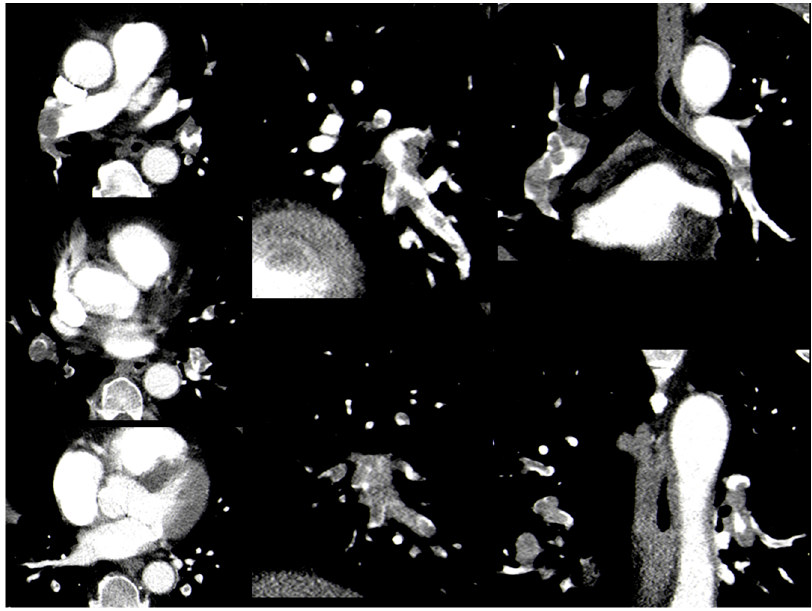
Figure 1. Case with bilateral pulmonary embolism. Total Mastora score is 65%.